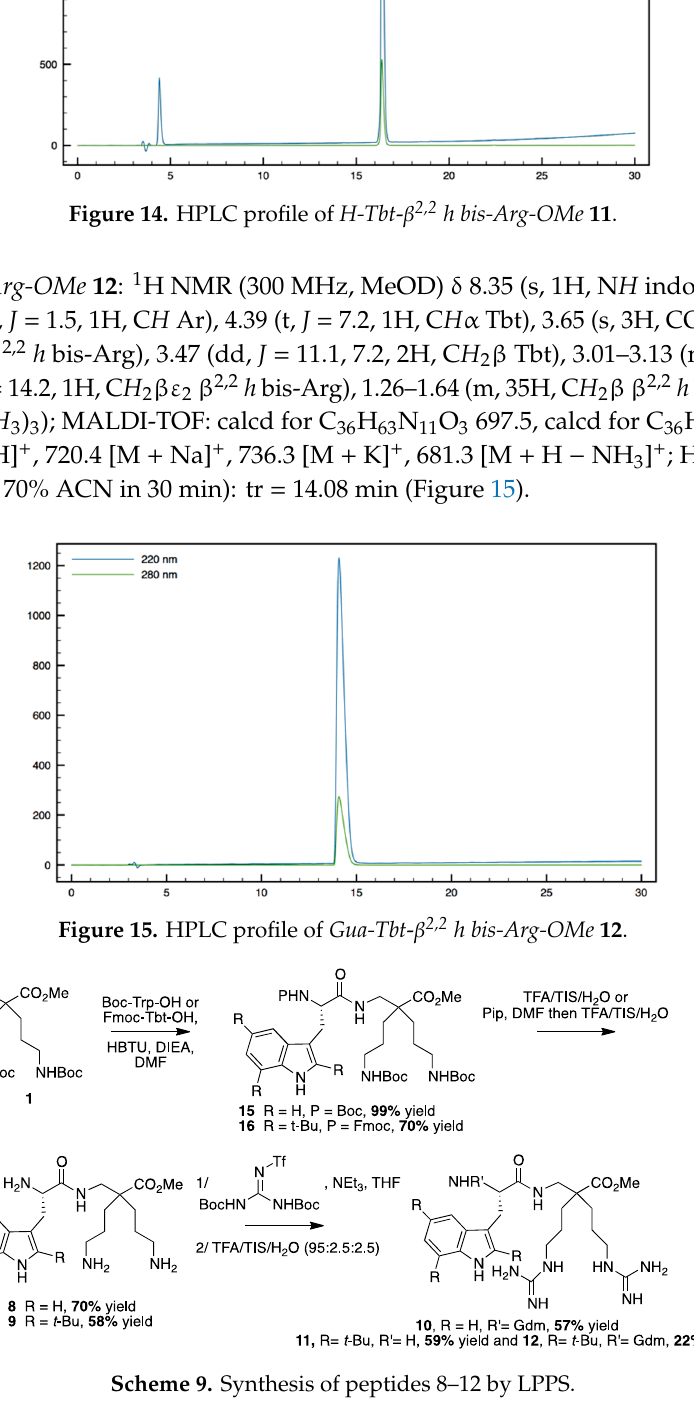
Scheme 9 . Synthesis of peptides 8–12 by